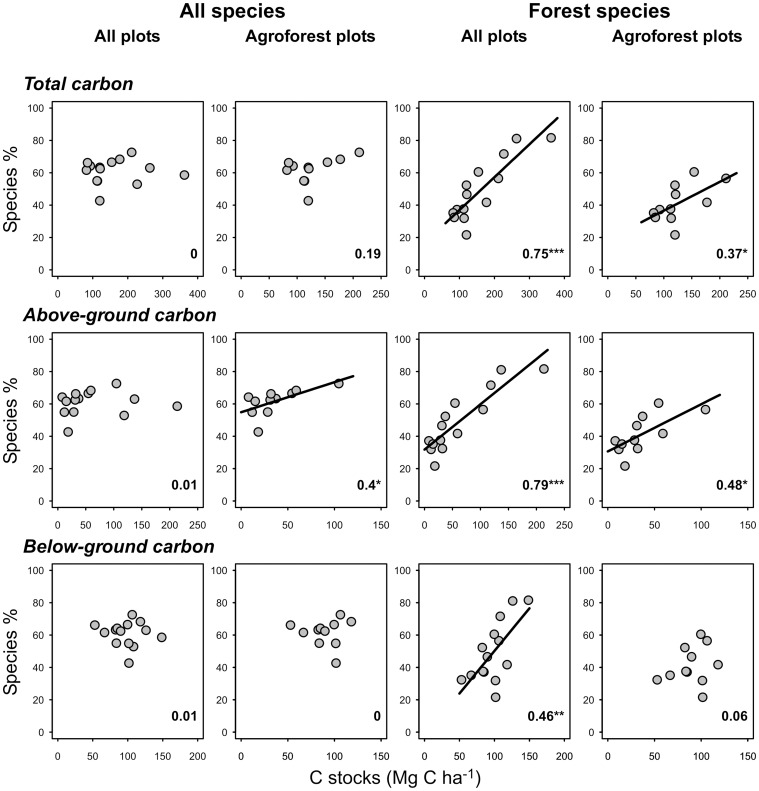
Relationships of species richness to carbon stocks.Relationships of species richness to carbon stocks, separated for all species and only those species recorded in the natural forest (forest species), for total, above-ground and below-ground carbon stocks as well as for all 14 study plots and only the 11 agroforest plots. To summarize the species richness patterns of the 12 focal plant and animal groups, richness values were all standardized to 100% relative to the highest plot values of each group and then averaged across all taxa. All individual relationships are shown in Figs. S1–3. Numbers in each graph are coefficients of determination (R2-values), trend lines are shown for significant relationships only. *p<0.05, **p<0.01, ***p<0.001.